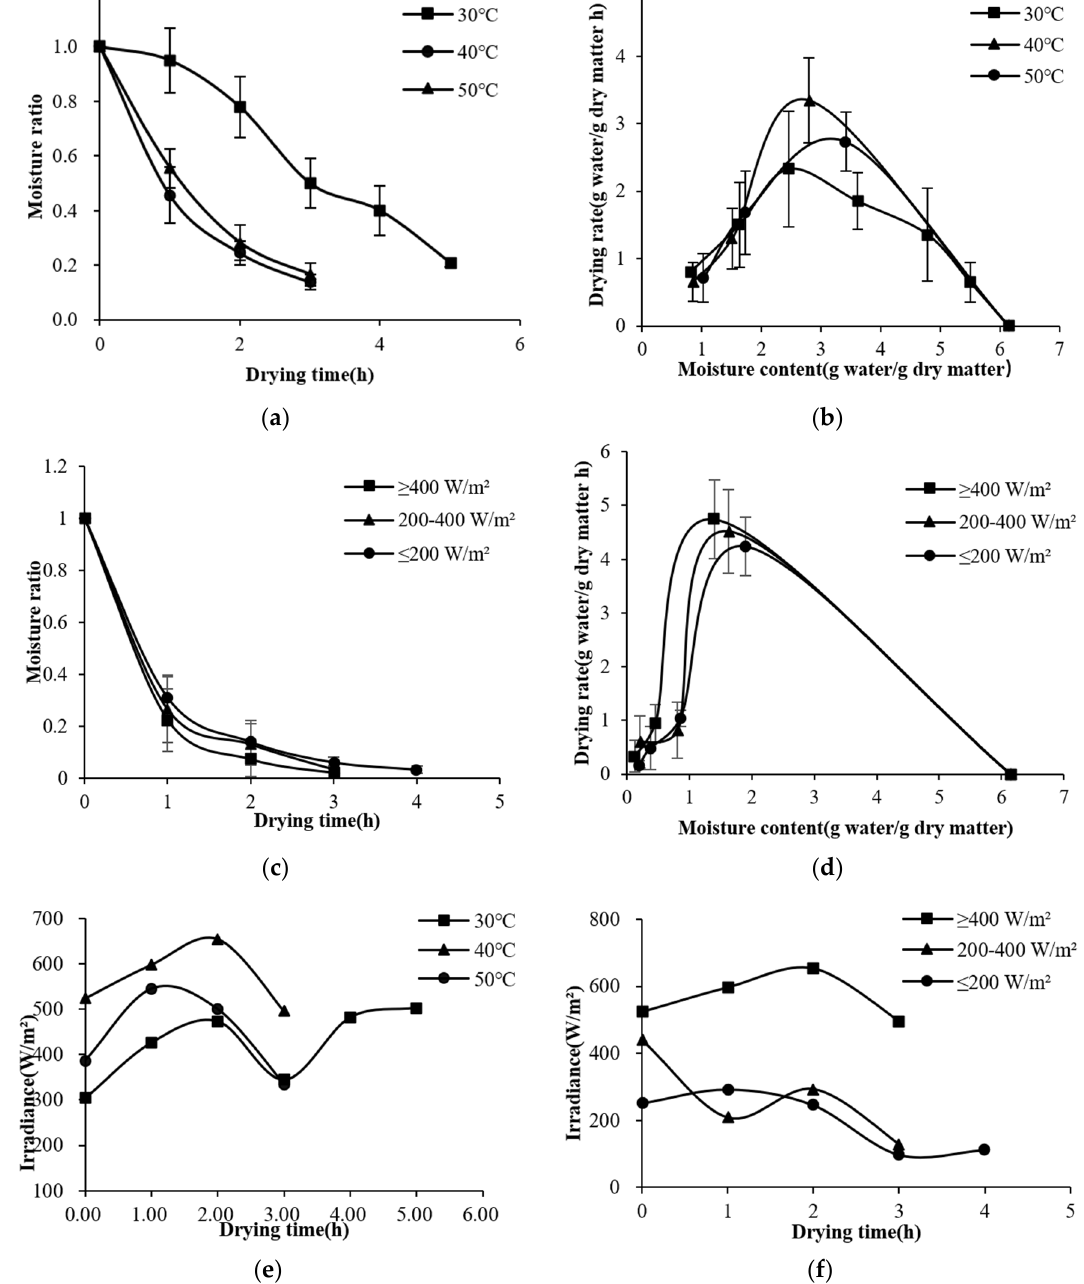
Figure 3. Moisture ratio ( a ) and drying rate ( b ) of kelp S − HP drying at different drying temperatures. Moisture ratio ( c ) and drying rate ( d ) of kelp S − HP drying under different irradiances. Irradiance curves under different drying conditions ( e , f ).